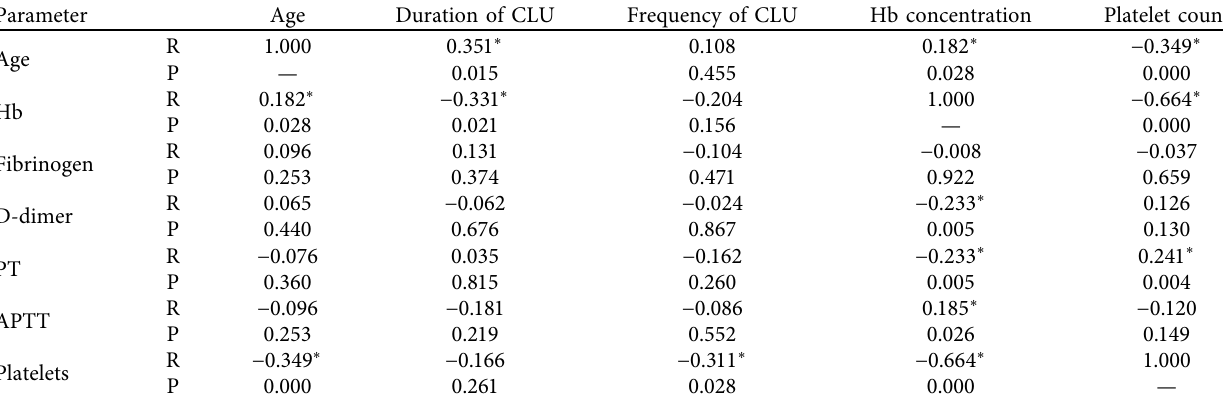
Table 4: Association between selected patients’ characteristics and coagulation